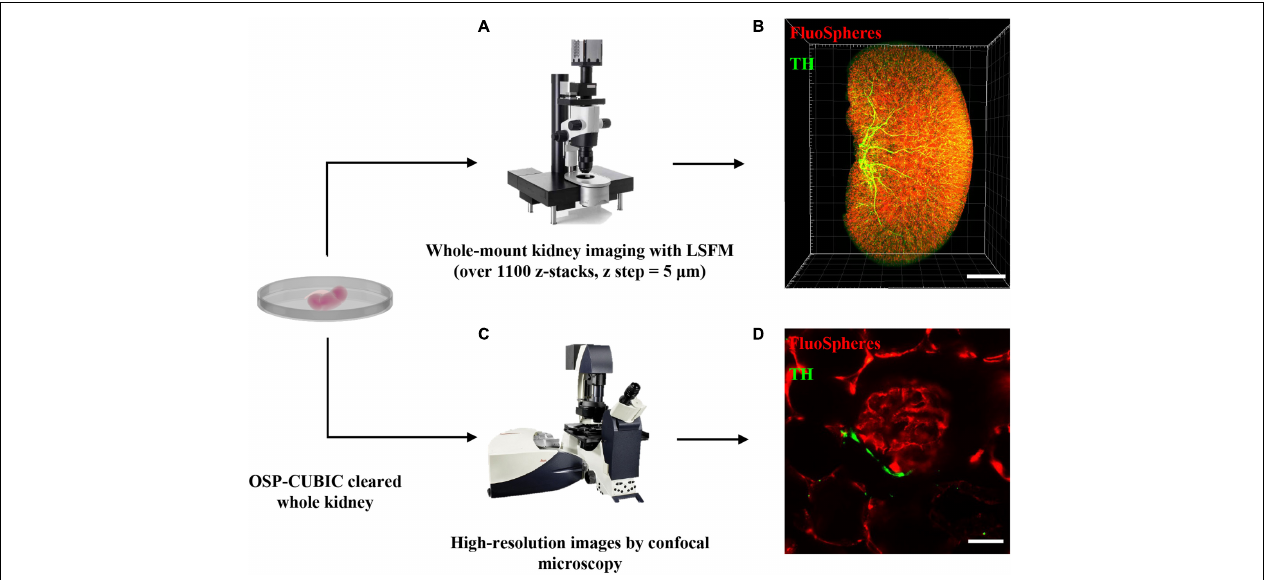
FIGURE 2 | Image acquisition of renal macro- and microstructures of the whole kidney by LSFM and confocal. The whole kidney after OSP-CUBIC clearing, 3D immunostaining, and RI matching was prepared for subsequent imaging. (A) Light-sheet fluorescence microscopy was used for whole-mount kidney imaging (over 1100 sections per kidney, z step = 5 µ m). (B) Three-dimensional reconstruction of the whole kidney, labeled with FluoSphere (microvasculature) and anti-TH antibody (sympathetic nerves). Scale bar = 2 mm. (C) To further acquire high-resolution images of local glomerulus and sympathetic innervation, confocal microscopy was used. (D) High-resolution imaging of the glomerulus and accompanying sympathetic nerve. Scale bar = 30 µ m. LSFM, light-sheet fluorescent microscopy; TH, tyrosine hydroxylase. Sympathetic nerves were labeled with anti-TH antibody (green). The microvasculature was labeled with FluoSphere